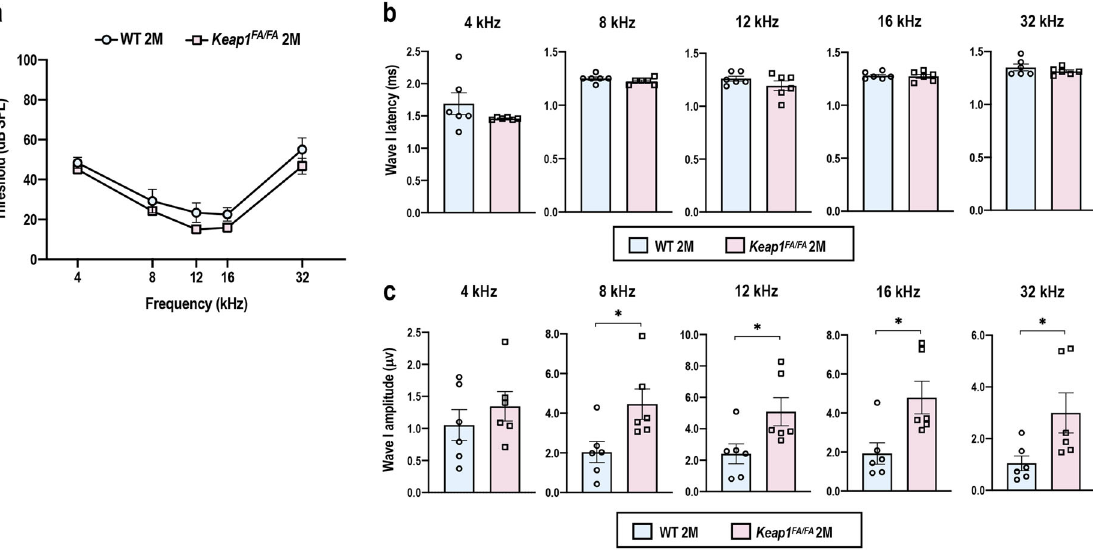
Fig. 6 Comparison of ABR of the WT and Keap1 FA/FA mice at 2 months of age. ABR thresholds ( a ), ABR wave I latencies ( b ), and ABR wave I amplitudes ( c ) of the WT and Keap1 FA/FA mice at the age of 2 months ( n = 6). The data represent the mean ± SEM. * P < 0.05. Unpaired two- tailed Student ’ s t -test was applied. The samples of the WT mice at 2 months of age are the same as those shown in Fig.